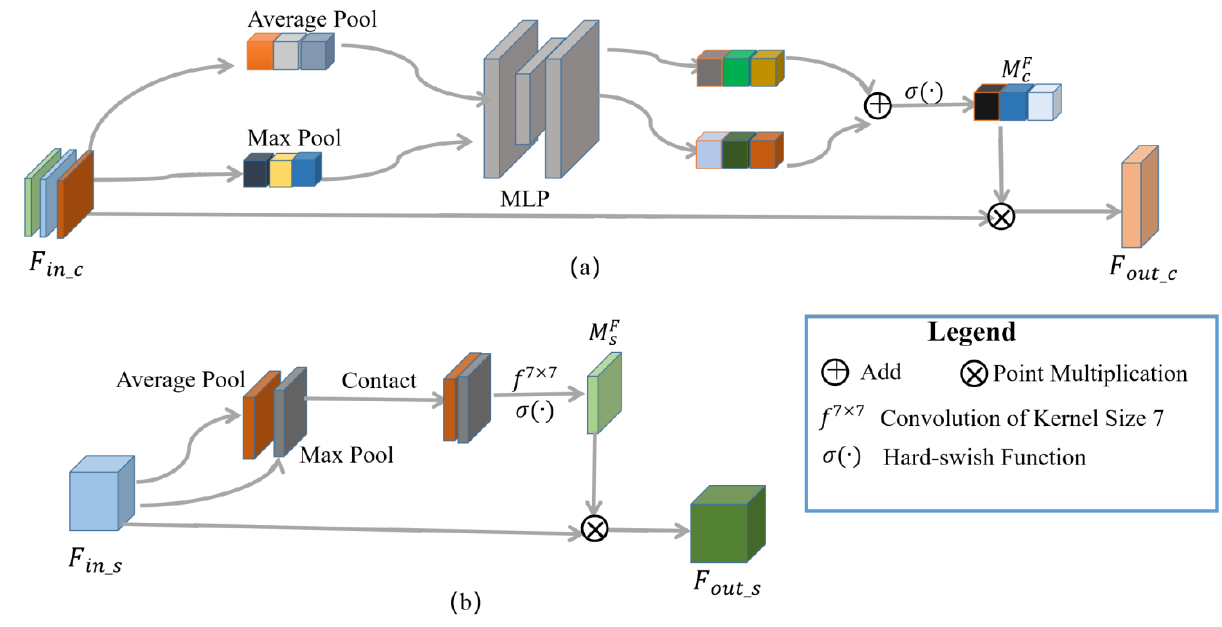
Figure 4. The architecture of the attention mechanism. ( a ) CAM; ( b )